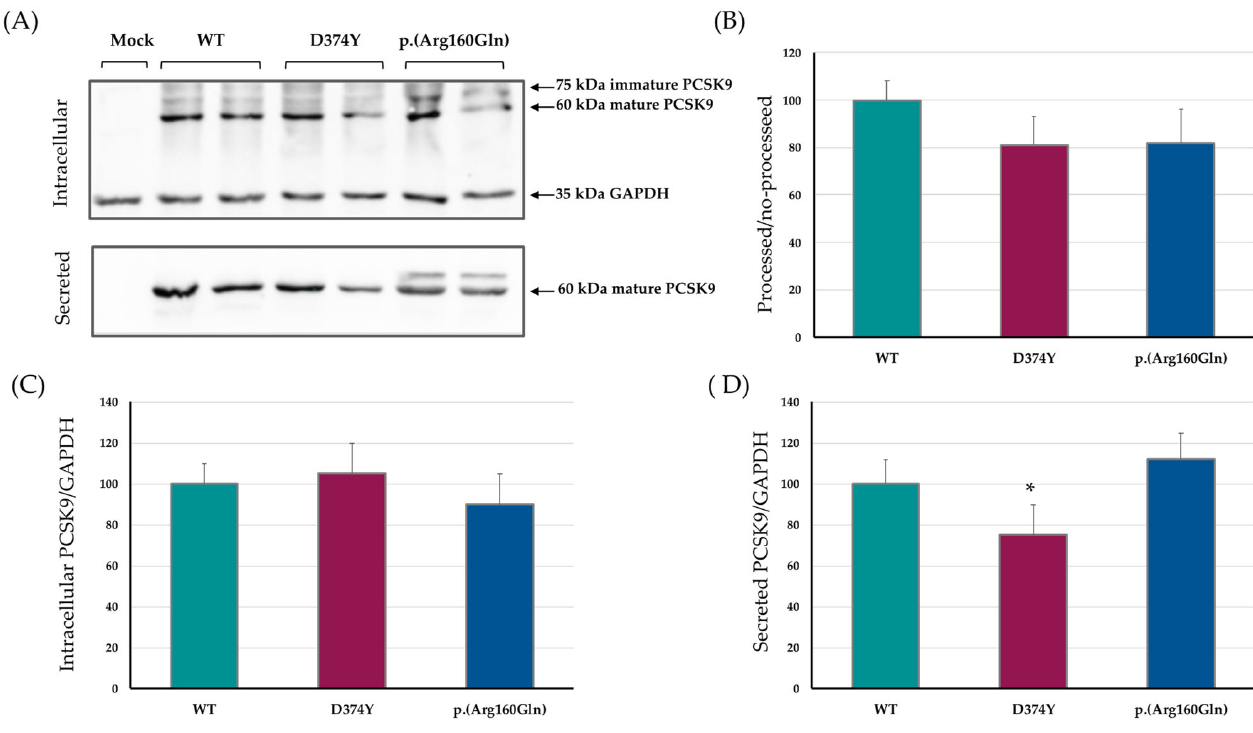
Figure 2. Expression, maturation and secretion of the p.(Arg160Gln) PCSK9 variant is similar to WT PCSK9. ( A ) Representative immunoblots of expression and secretion of PCSK9 on HEK293 cells transiently transfected with mock (empty plasmid), WT, D374Y and p.(Arg160Gln). ( B ) Ratio between processed/non-processed PCSK9 quantified by densitometry. ( C ) Amount of expressed PCSK9 determined as the ratio between intracellular PCSK9/GAPDH quantified by densitometry. ( D ) Amount of secreted PCSK9 determined as the ratio between media/GAPDH quantified by densitometry. Histograms represent the mean ± SD of three independent experiments. * p < 0.05 compared to WT PCSK9.